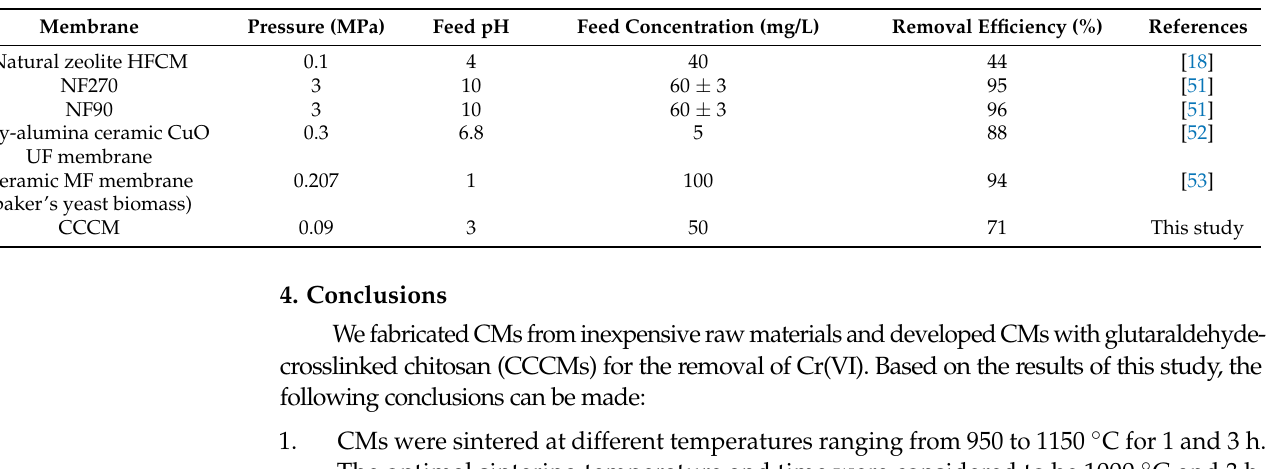
Table 4. Comparison of the removal efficiency of Cr(VI) using different combined